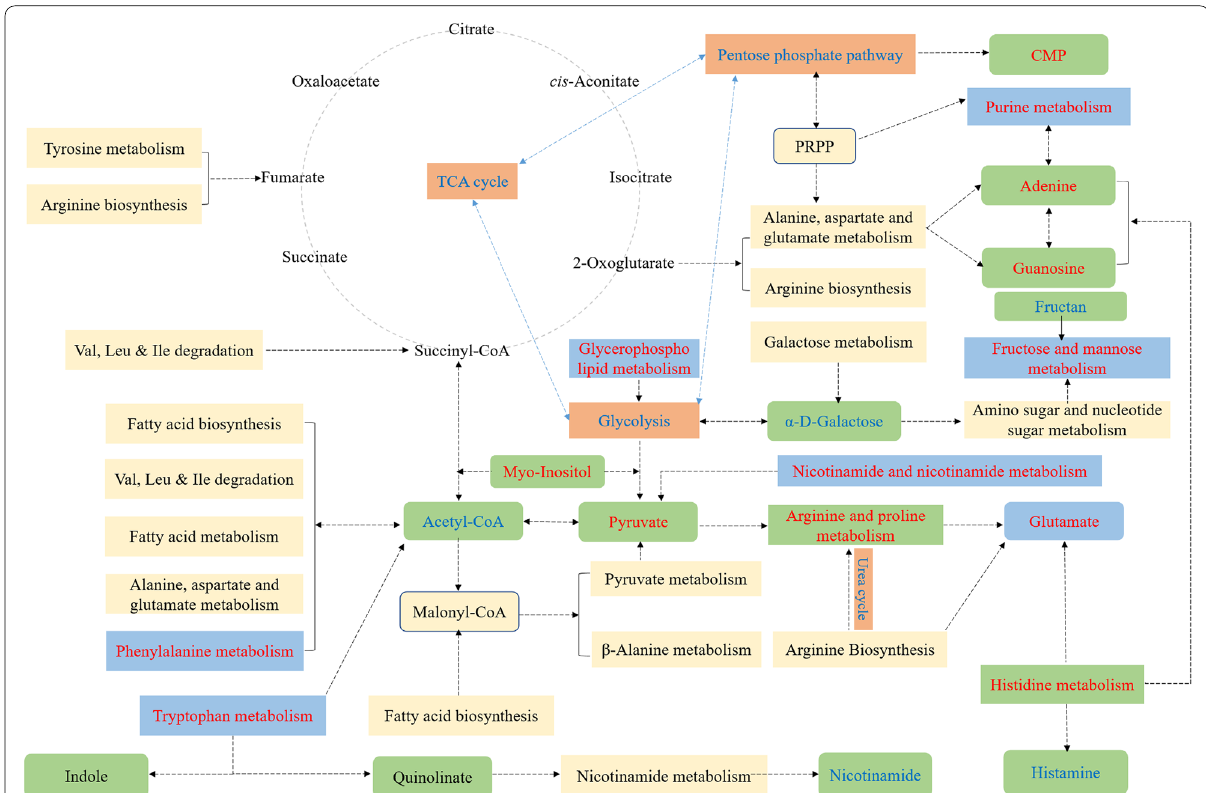
Fig. 8 Integration map of some metabolic pathways of recombinant B. subtilis and E. coli and related differential metabolites. The pathways were obtained from the KEGG database and modified appropriately. Red indicates that some key differential metabolites and metabolic pathways in the process of co-fermentation are upregulated, and similarly blue indicates